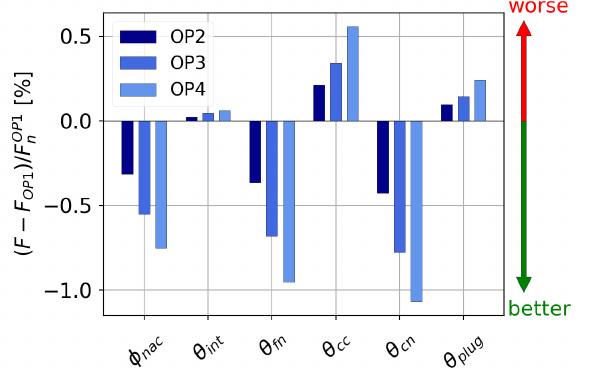
Figure 10. Absolute percentage variation from OP1 of forces acting on the nacelle walls, normalised to F OP 1 n